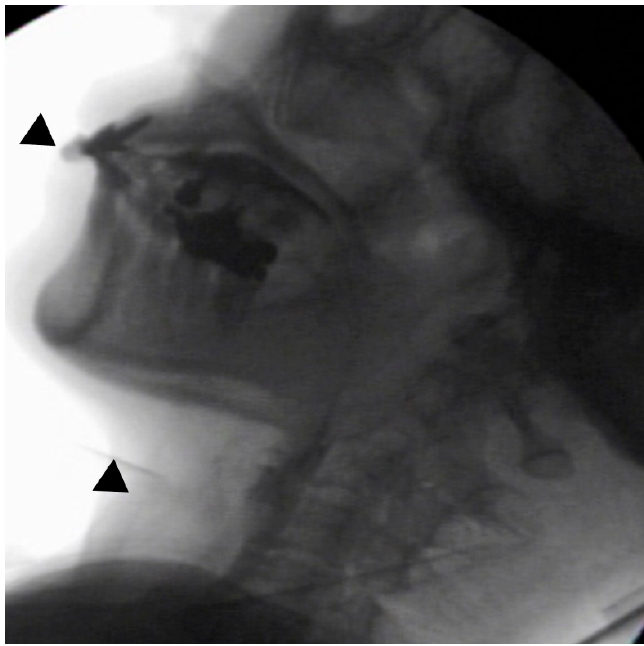
Figure 2. The patient was reclined at 30° for the administration of 5 mL of an extremely thick paste. Oral transport was better than in the sitting position; furthermore, a little of the food dribbled out of the mouth (above ▲ ), and no aspiration occurred (below ▲ ).